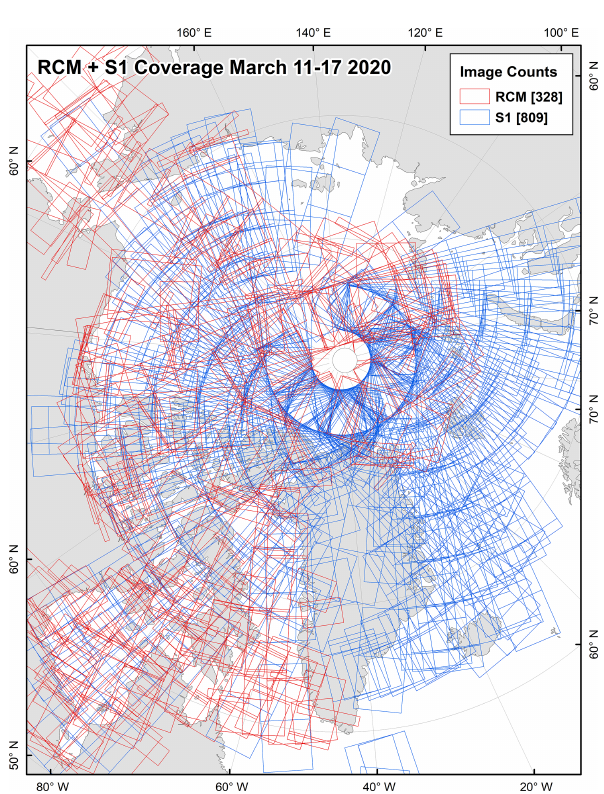
Figure 5. Spatial distribution of S1 and RCM SAR images from 11–17 March